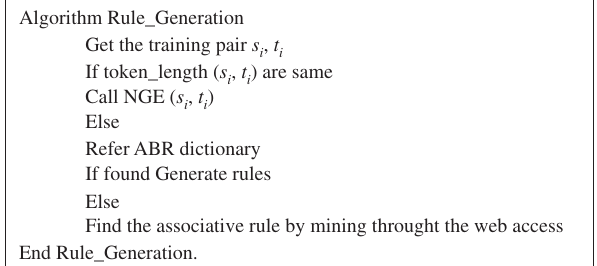
Algorithm Rule_Generation